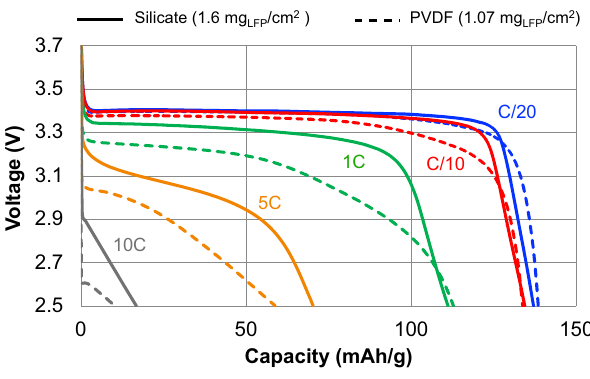
Fig. 4 Rate comparison between LFP electrodes using silicate (1.6 mg LFP / cm 2 loading) and PVDF (1.07 mg LFP /cm 2 loading) binder in lithium half cells. Voltage curves of the sample produced using silicate demonstrate excellent charge transport.